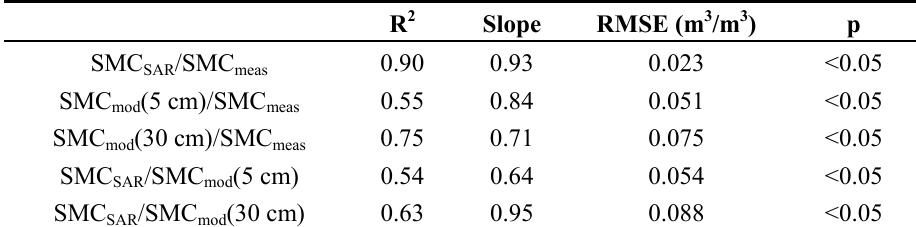
Table 3. Statistical parameters (R 2 , Slope, RMSE, in m 3 /m 3 , and p) of all the performed regression equations between SMC estimated from SAR (SMC hydrological model (SMC ) at two depths (5 and 30 cm), and the SMC measured on mod ground (SMC meas